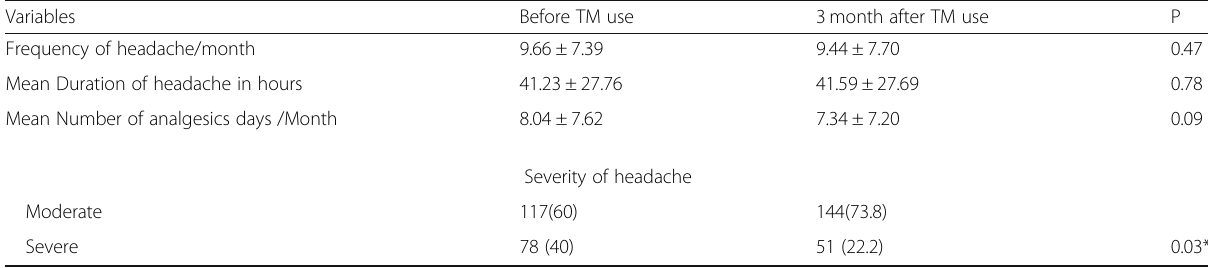
Table 3 self-reported efficacy of TM (N = 195) Variables Before TM use 3 month after TM use